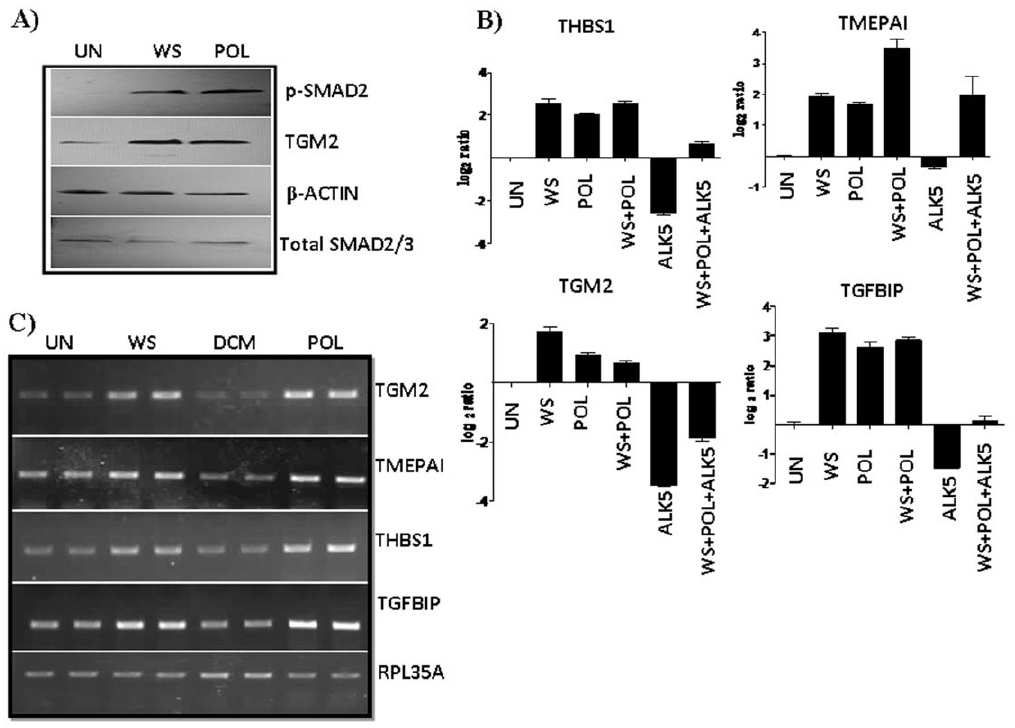
Figure 3. Alkaloid and Polyphenol fractions of Areca nut induce TGF- b signaling in HaCaT cells. Treatment of HaCaT cells with both the Alkaloid and Polyphenol fractions of areca nut water extract induced TGF- b signaling (p-SMAD2) and its down-stream target TGM2 as shown by the western blot (Figure 3A). Expression of TGF- b down-stream targets were also studied by Real Time PCR (Figure 3B) and semi quantitative PCR (Figure 3C). Induction of genes by alkaloid and polyphenol fractions of areca nut was compromised in presence of T b RI inhibitor (ALK5 inhibitor). (UN- untreated, WS- water supernatant, POL- Polyphenol supernatant, DCM- Dichloromethane fraction).